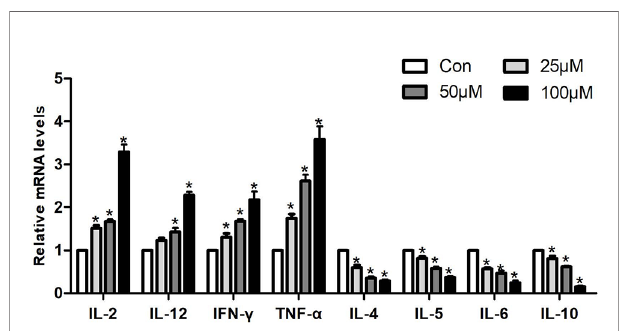
FIGURE 5 | Effects of Sch B on Th1/Th2 imbalance in Hepa1-6 cells. Related Th1/Th2 cytokine mRNA levels with 0-, 25-, 50-, and 100- m M Sch B treatment in Hepa1-6 cells. ∗ shows a signi fi cant difference from the corresponding control ( P < 0.05). n